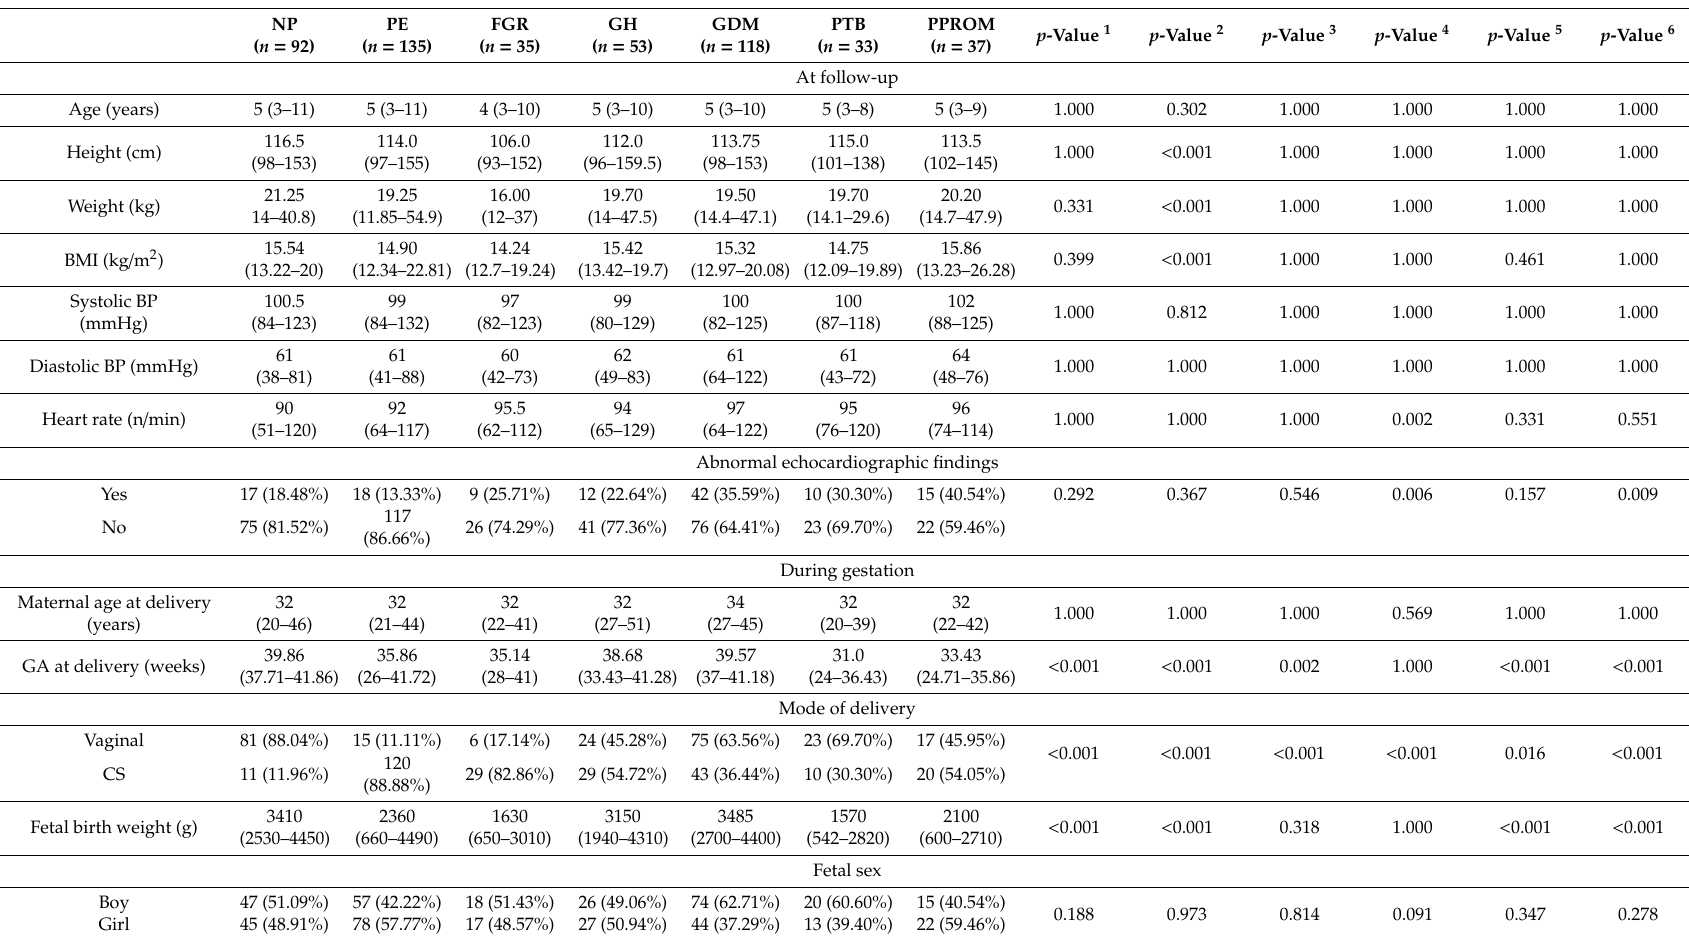
Table 1. Characteristics of cases and